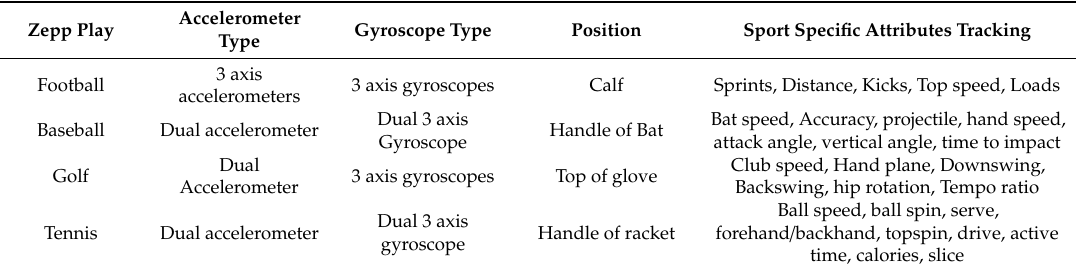
Table 6. Accelerometer and gyroscope combinations in Zepp wearable for di ff erent sport applications; data taken from Zepp